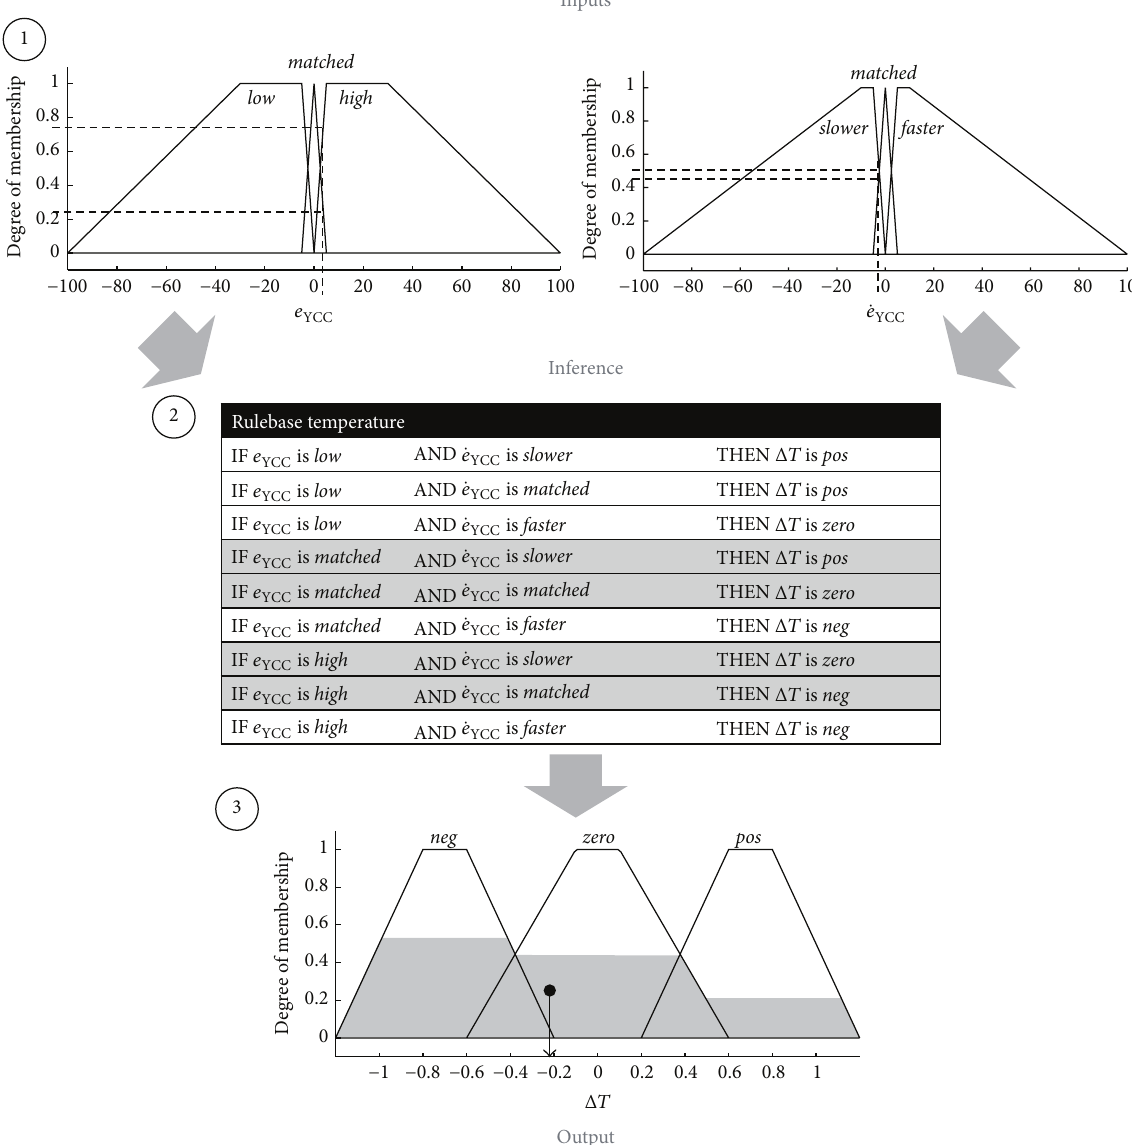
Figure 2: Schematic representation of the nontuned fuzzy controller structure and the flow of information. The first step shows the fuzzy and ̇𝑒 into their specific fuzzy sets. The second step diagrammatically shows the partition and the fuzzification of the input variables 𝑒 YCC YCC inference mechanism and the activation of the corresponding rules in the rulebase. The third step illustrates the set partition of the fuzzy output variable Δ𝑇 and the accumulation and COG defuzzification of the overall implied fuzzy set into a crisp output.